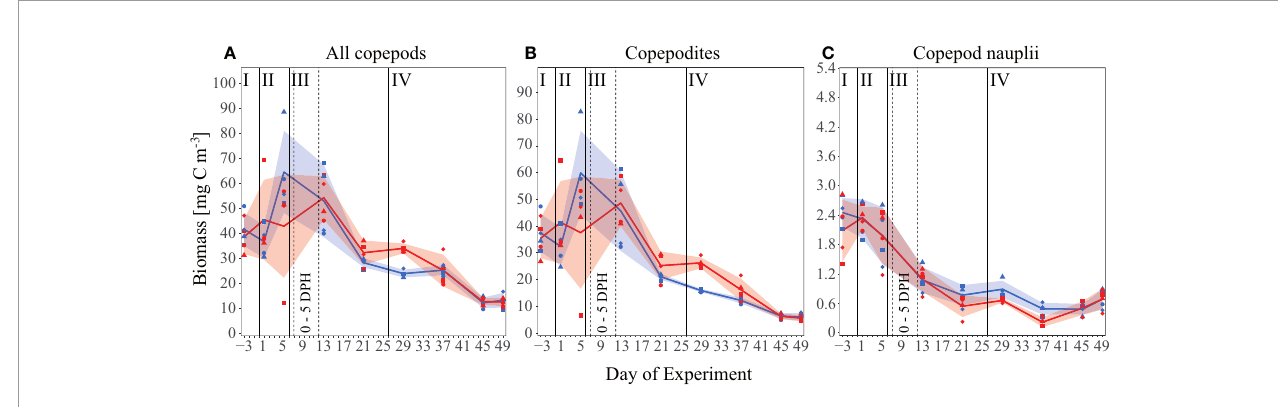
FIGURE 3 | Biomass [mg C m -3 ] development of all measured copepod species over the time of the experiment as (A) all copepod species and size classes combined (i.e. including adult, copepodite and nauplii stages), (B) only copepodite stages, and (C) only copepod nauplii larvae. Lines, symbols and colors are used as described in Figures 1C , Figure 2